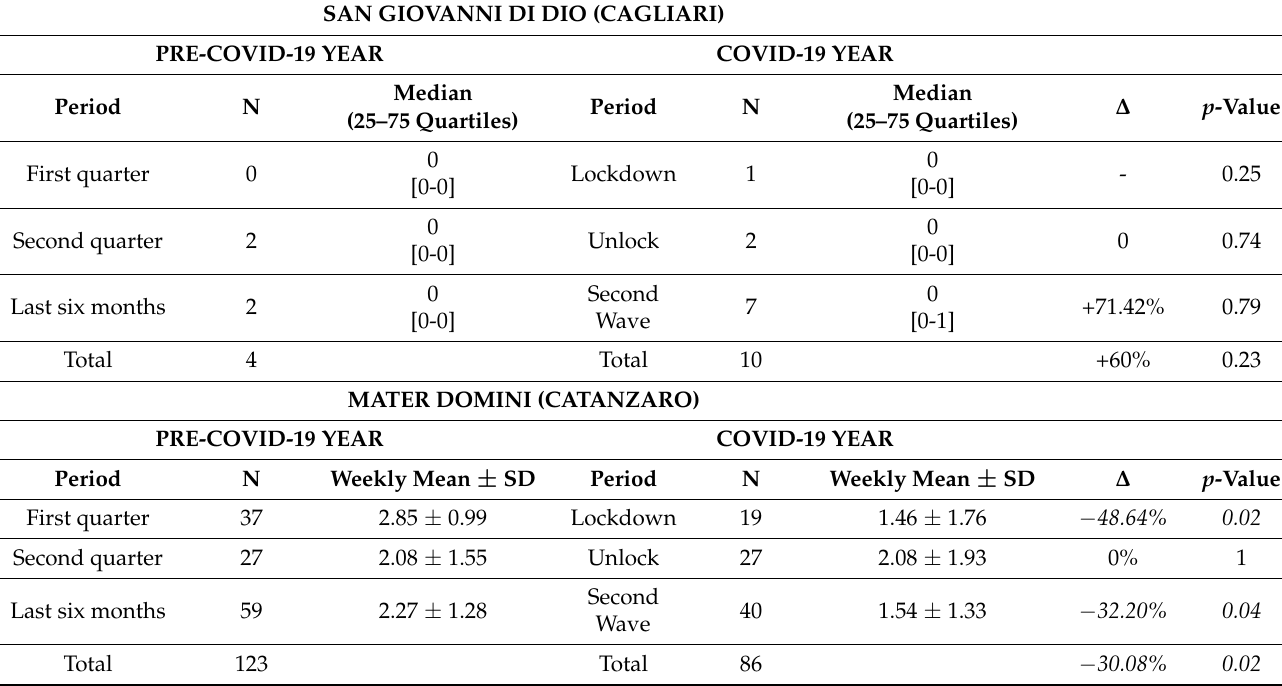
Table 1. Number of anterior segment procedures performed at San Giovanni di Dio (SGD), University of Cagliari, and Mater Domini, University Magna Græcia of Catanzaro (UMG), divided by periods of lockdown, unlock, and second wave,